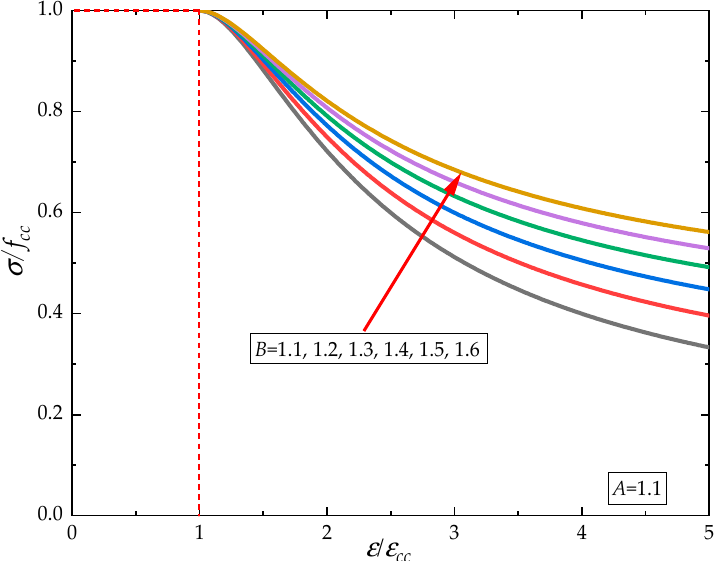
Figure 13. Effect of model parameter B on the descending portion of the complete curve. Based on the geometric conditions of the complete curve equation, A = E c ε cc / f model parameter B depends on the value of the residual stress in the descending portion, which is mainly related to the concrete strength and lateral confining stresses. In this study, the experimental results of related studies [24–33] were collected to establish the empirical formula of residual stress. Here, the unconfined concrete strength ranges from 60 MPa to 120 MPa, and the lateral confinement ratio is 0–0.5. The relationship between residual stress, concrete strength, and peak strength of confined concrete is shown in Figures 14 and 15.